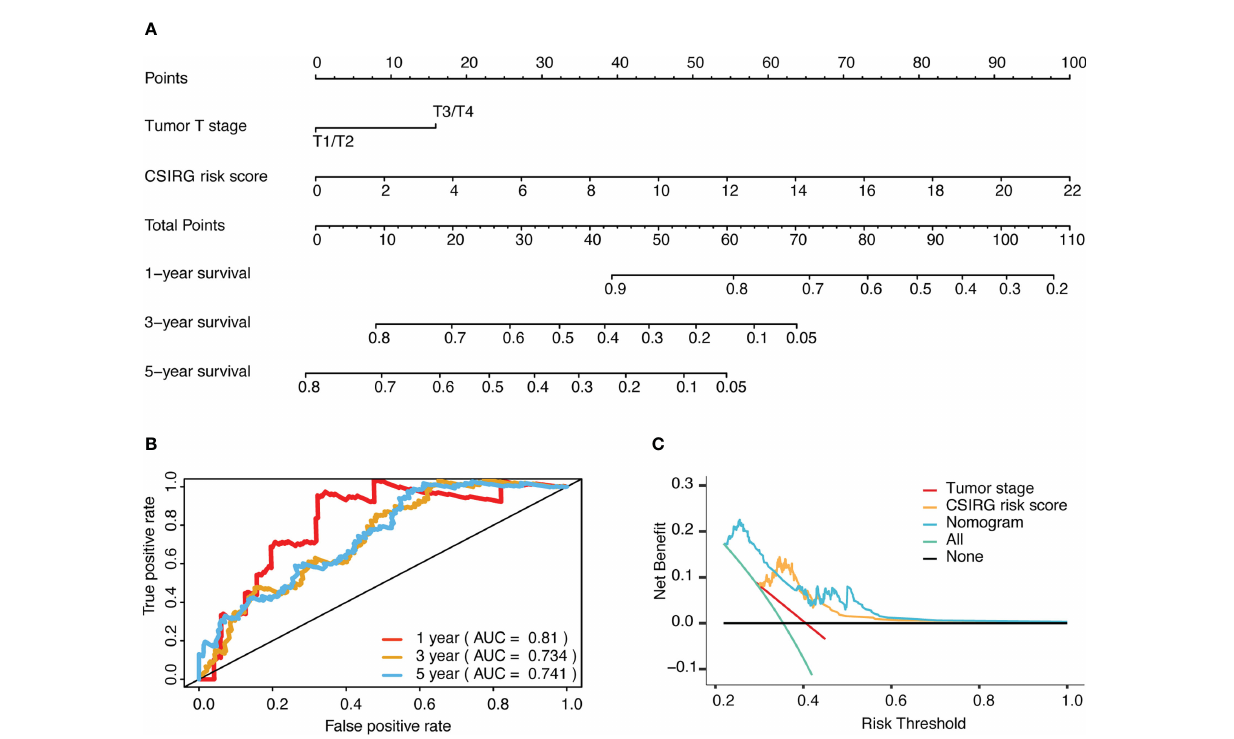
Characteristics